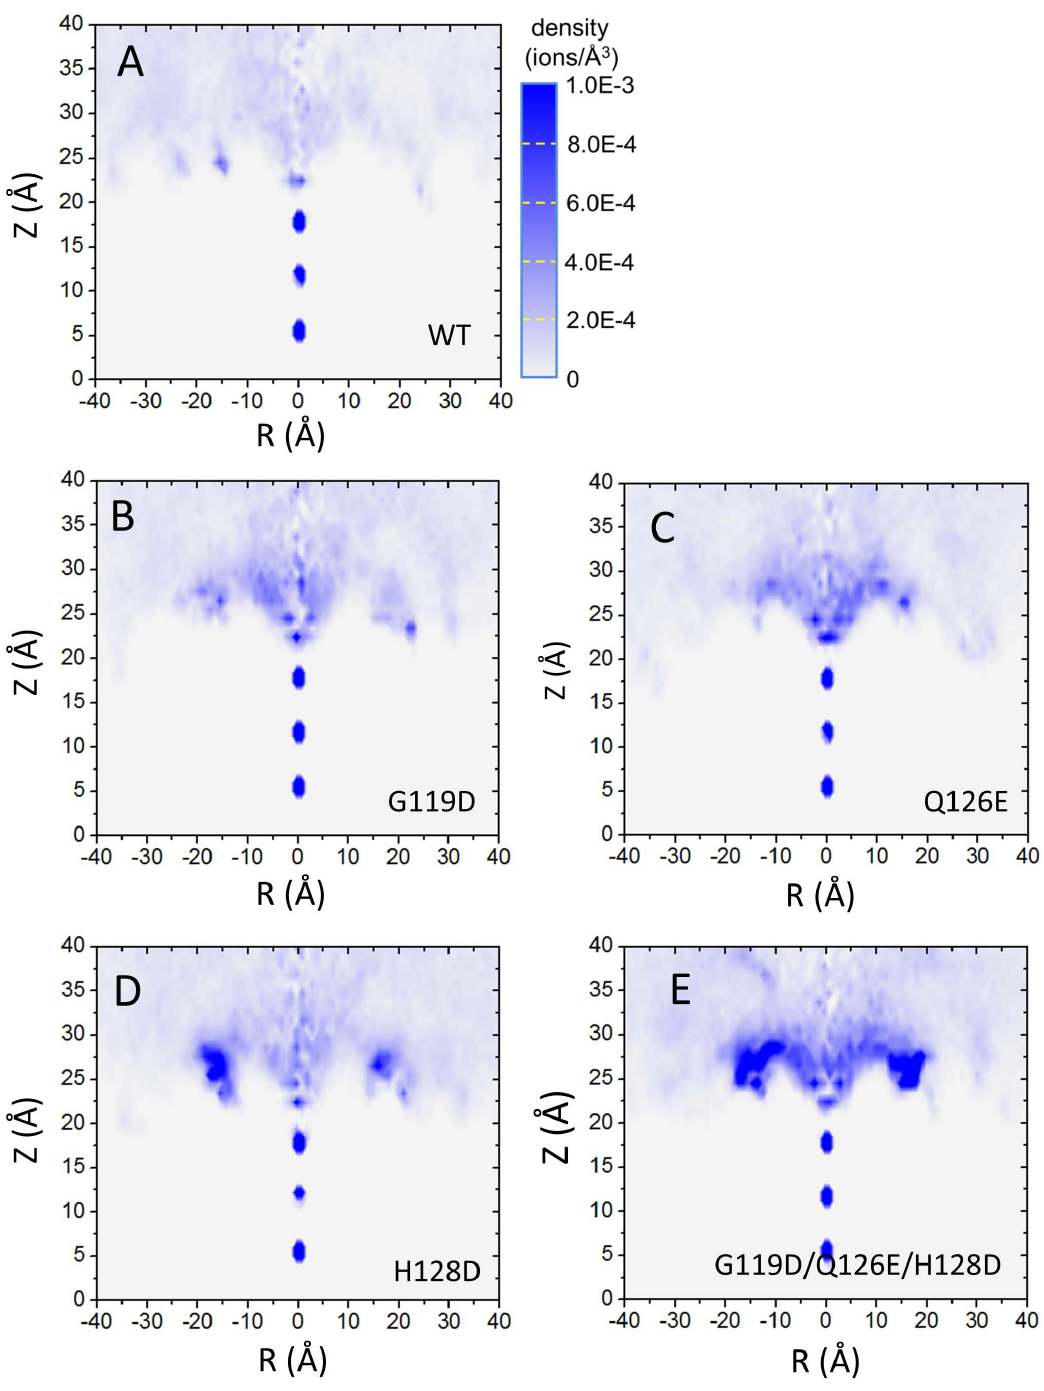
Figure 7. Extracellular K + density distribution in Kir2.2 and its mutants. The simulations of the Kir2.2 and its mutants were carried out in 0.15 M K + . The extracellular K + density plots are shown as functions of radial distance from the pore axis ( R= ( x 2 + y 2 ) 1/2 ) and height in the simulation box (Z). K + density distribution in Kir2.2 WT (A), G119D (B), Q126E (C), H128D (D) and Triplet mutant (G119D, Q126E and H128D) channels (E).